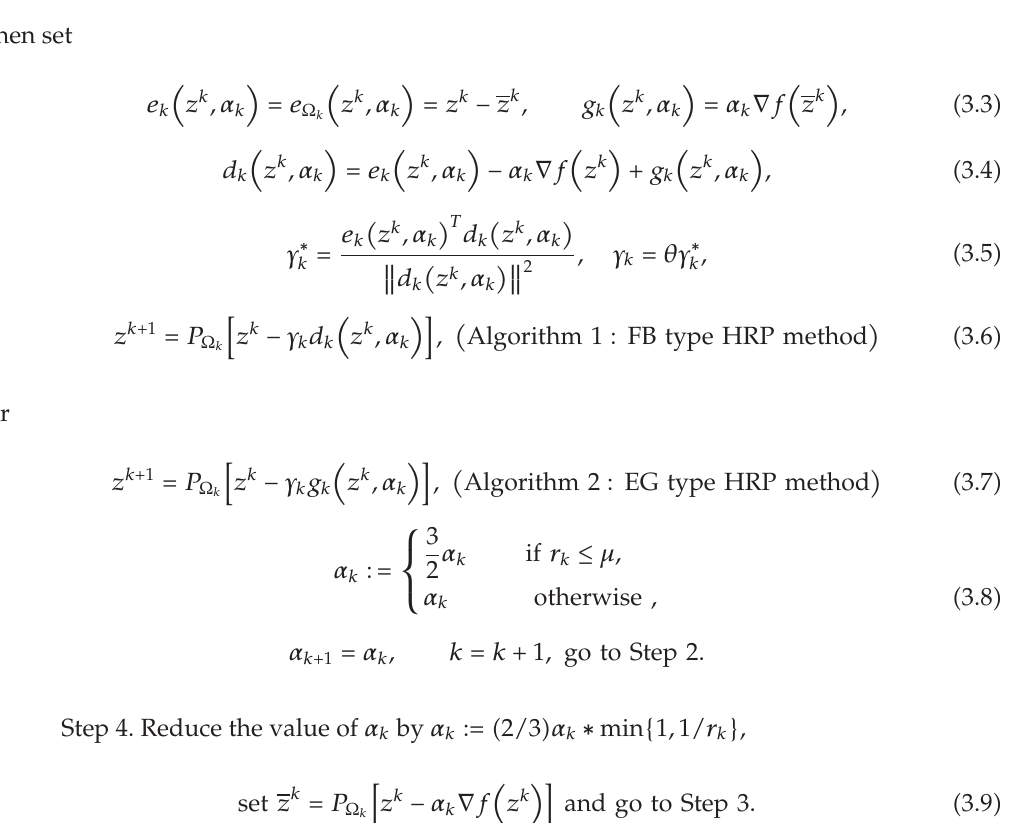
Algorithm 1 : FB type HRP method